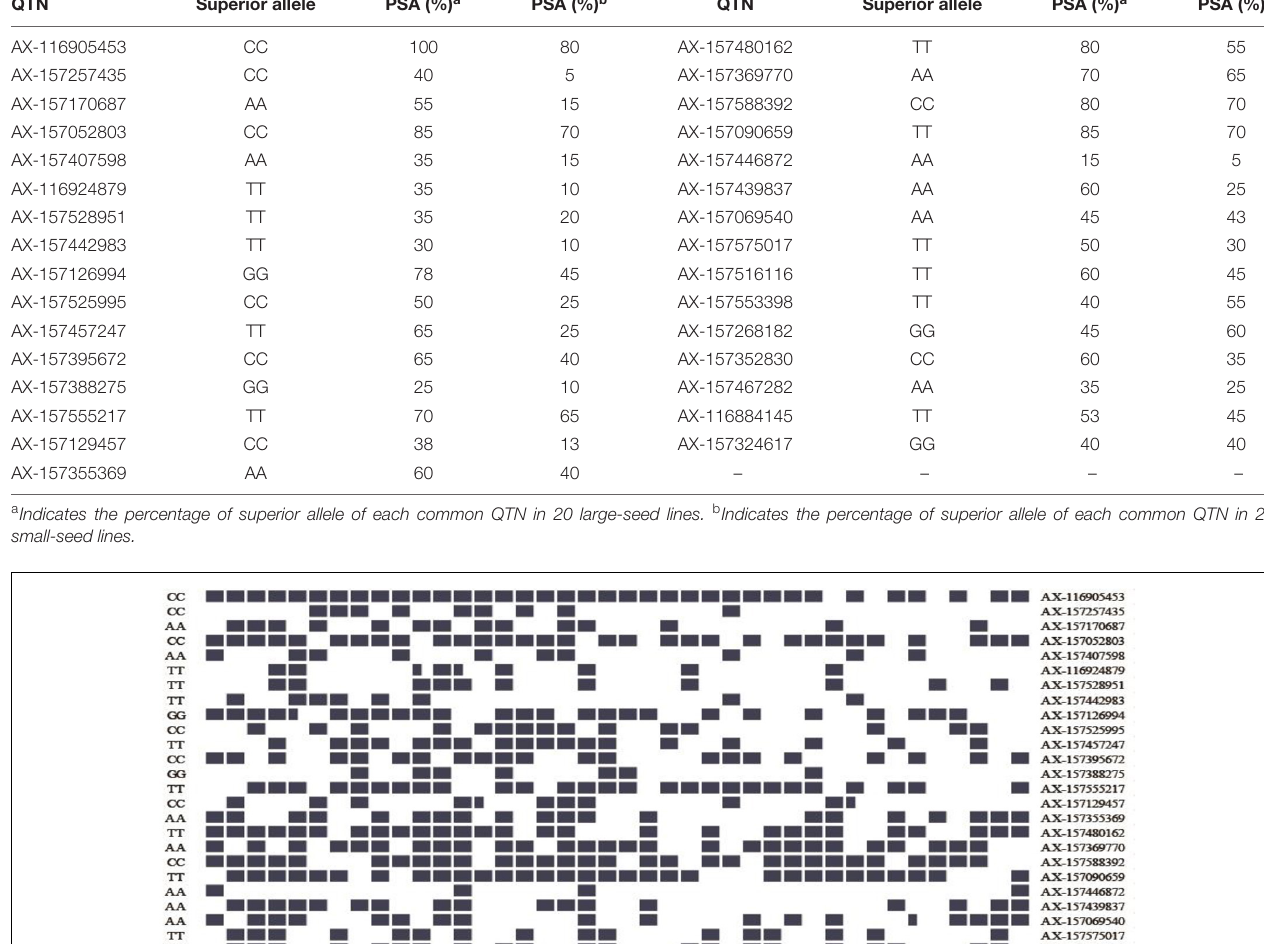
Distribution of Superior Alleles in the FW-RILs We identified 20 large-seed lines with high HSW and 20 small- seed lines with low HSW based on the average phenotypic values of 144 FW-RILs in 20 environments ( Table 4 ). The HSW phenotypic values of the 20 large-seed lines ranged from 20.65 to 22.55 g. For each large-seed line, the percentage of superior alleles (PSAs) for the 31 common QTNs ranged from 35 to 77%; nine lines (45%) showed a PSA of less than 50%. The phenotypic values for the 20 small-seed lines ranged from 16.53 to 17.79 g, and the PSA ranged from 21 to 52% ( Table 4 ). Therefore, the large-seed lines had a higher PSA than the small-seed lines ( Figure 5 ).